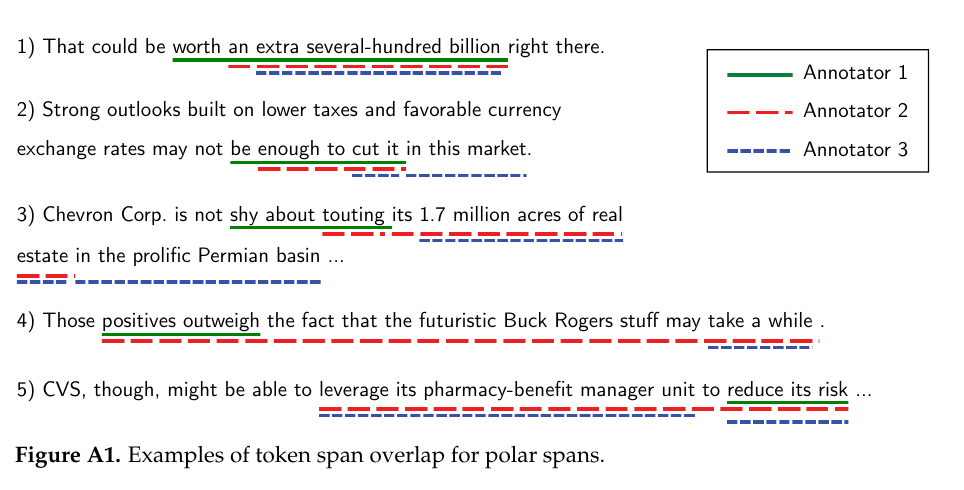
Figure A1. Examples of token span overlap for polar spans.